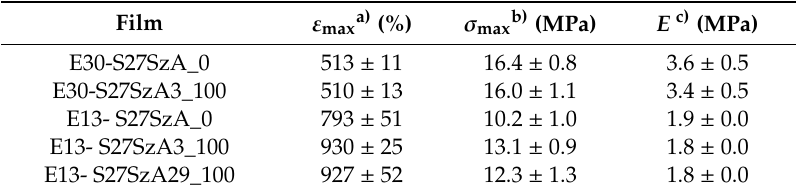
Figure 5. Stress-strain curves for E30-S27SzA3_100 ( a ) and E13-S27SzA3_100 ( b ). Table 4. Tensile test results for poly(styrene- b -(ethylene- co -butylene)- b -styrene) (SEBS)-based films and the corresponding SEBS (E30/E30-MA and E13/E13-MA) matrices.